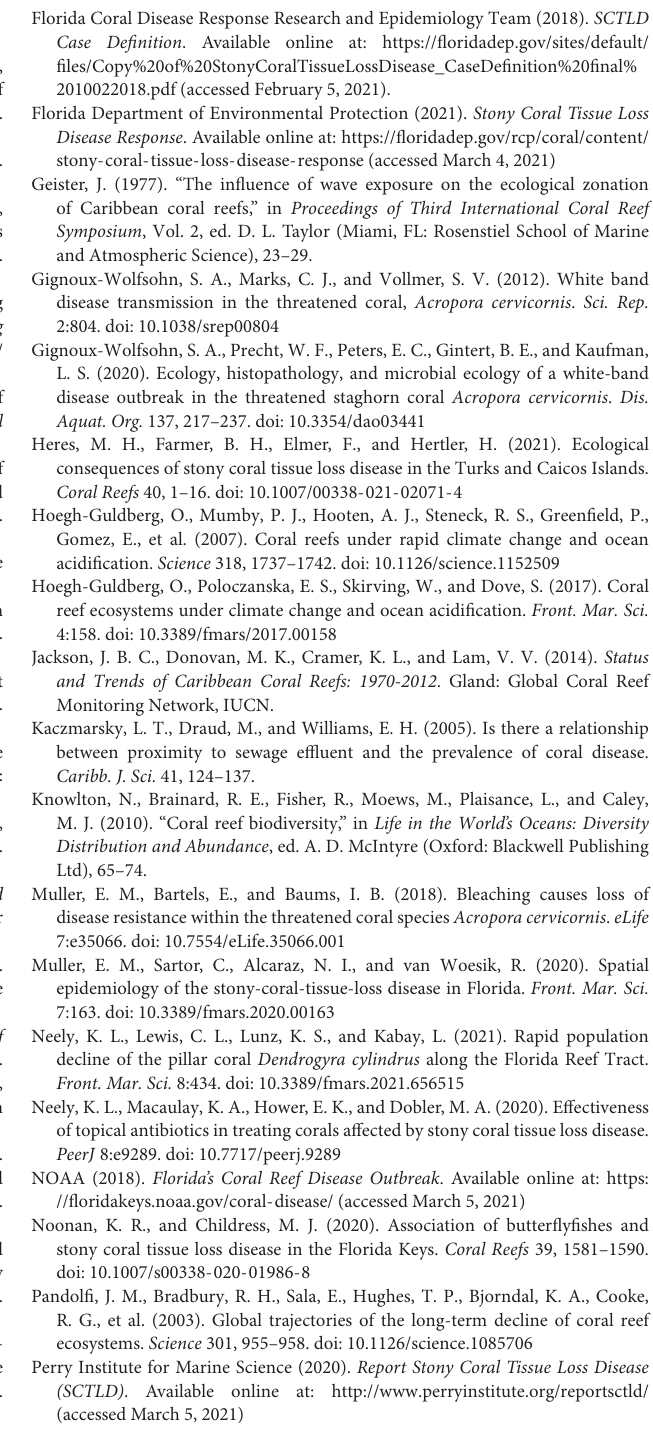
Supplementary Figure 1 | Proportion of colonies from Grand Bahama (GB; top two rows) and New Providence (NP; bottom two rows) that were healthy (H, left), infected with SCTLD (middle) or experienced recent mortality (RM, right) for Diploria labyrinthiformis (DLAB) and Siderastrea siderea (SSID) plotted against distance east and west of the port facility (Distance = 0). Deep reefs ( > 10 m) are shown in black and shallow reefs ( ≤ 10 m) in